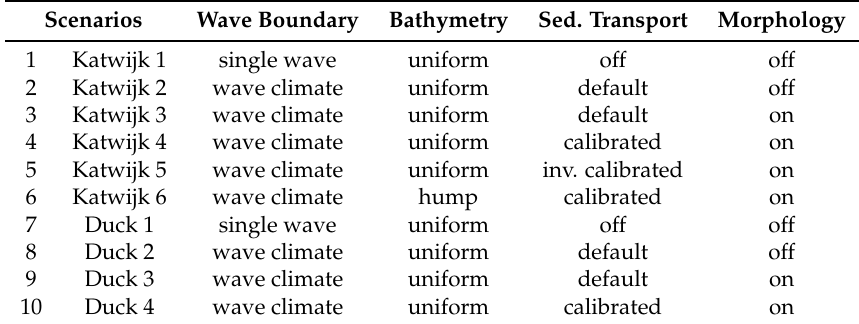
Table 1. Overall summary of performed numerical simulations. Wave conditions are described in Table 2 being wave 7 the single-averaged wave condition and wave climate refers to all schematized waves (Table 2); Default and calibration stand for sediment transport multiplication factors, being default equal to one and calibration values are presented in Table 3. All scenarios were performed for IH and RUE